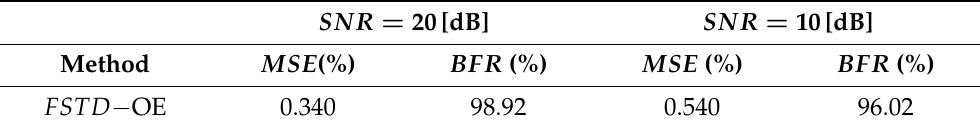
Table 4. BFR and MSE obtained by the FSTD - OE algorithm ( nmc = 200runs, SNR y = 20 and10[dB]): example 2.